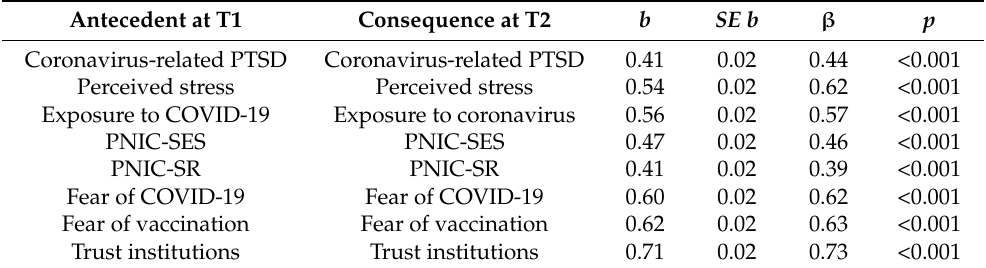
Table 2. Regression of the associations between variables at T1 and T2 ( N = 1723). Antecedent at